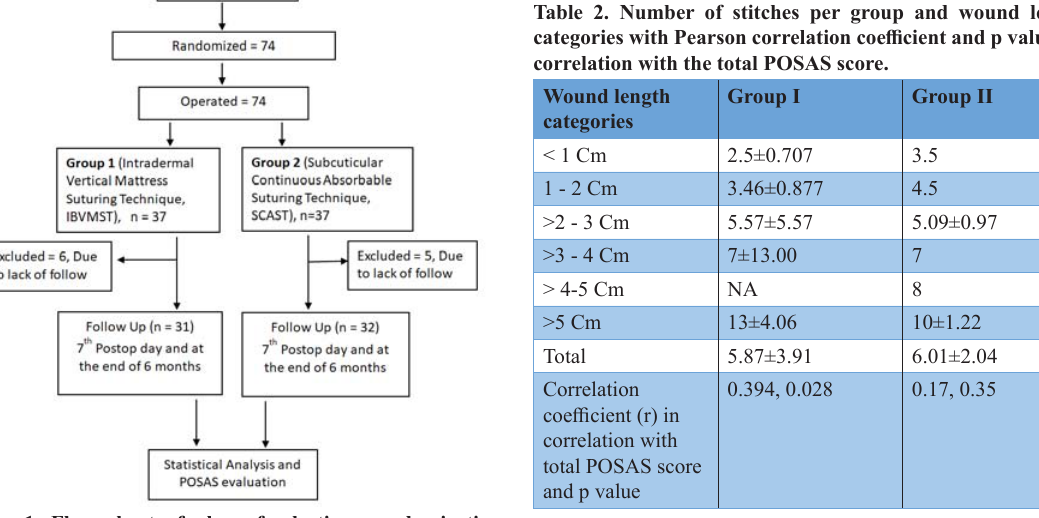
Table 2. Number of stitches per group and wound length